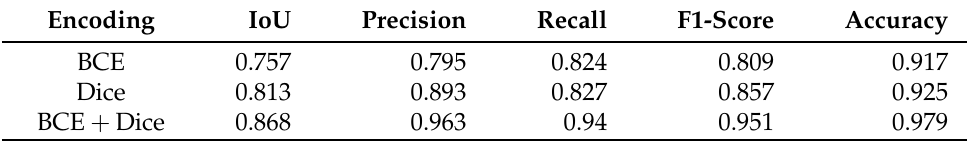
Table 5. Effect of different loss functions.